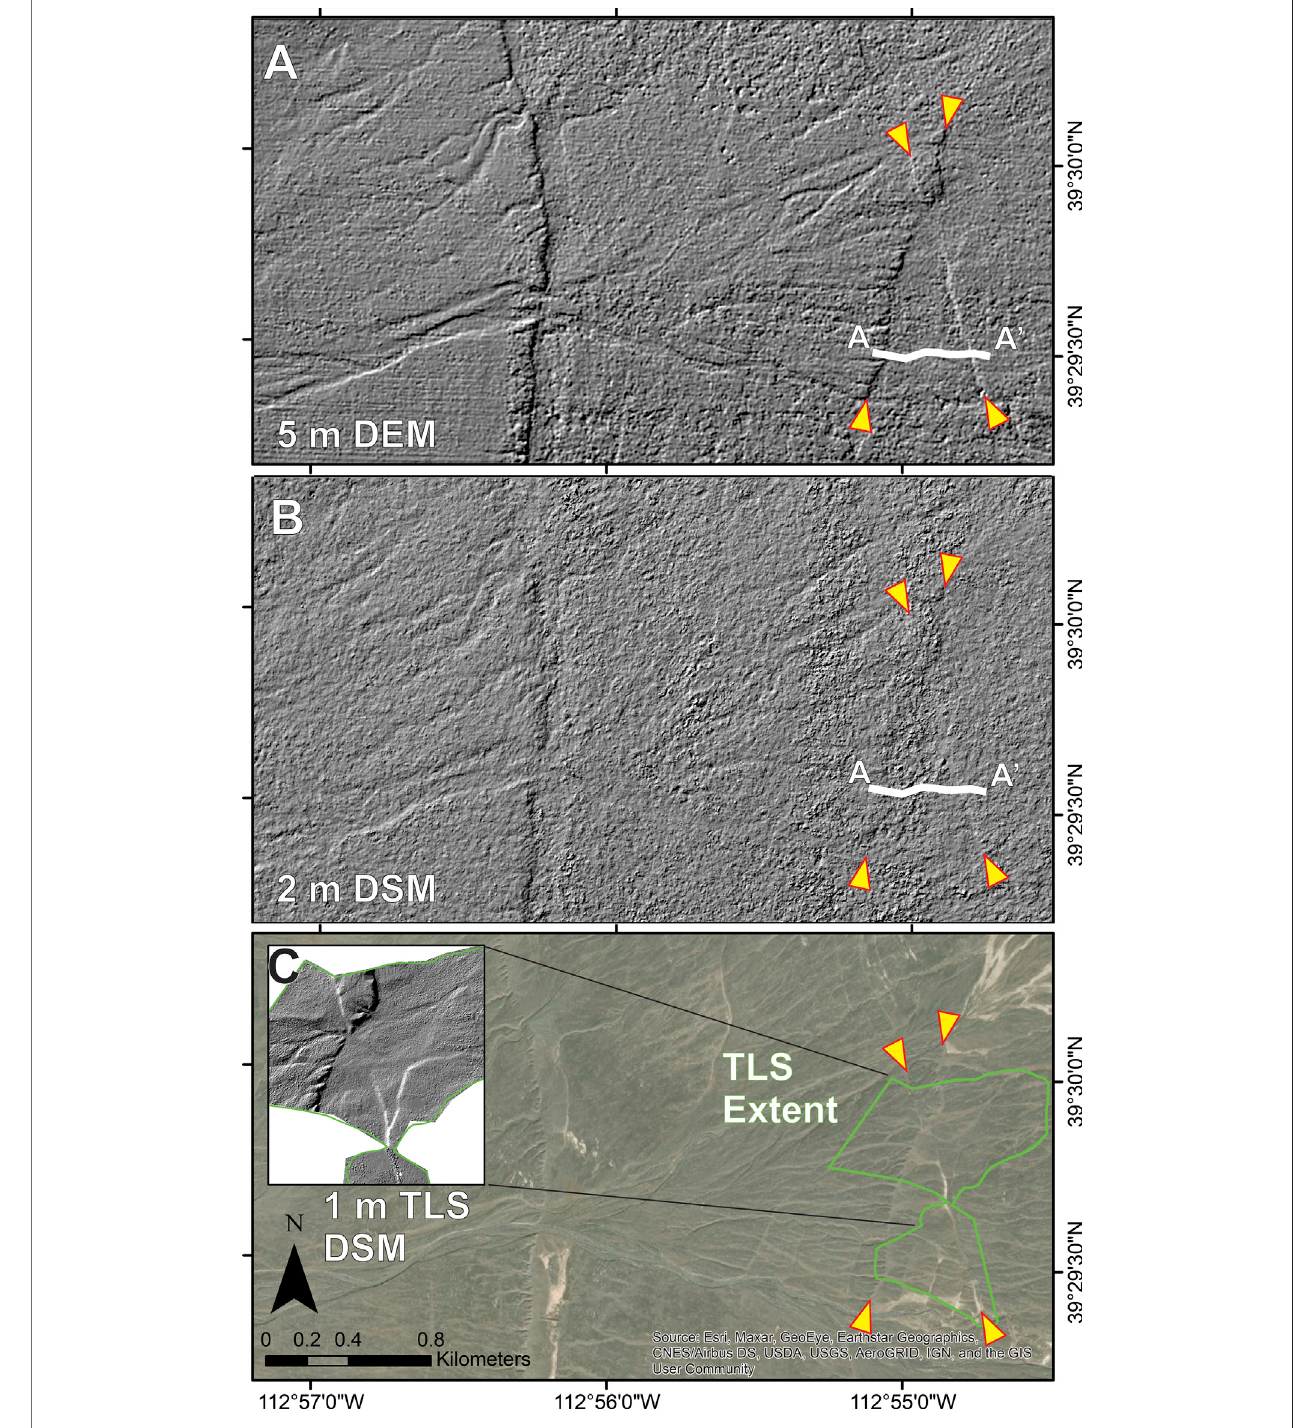
FIGURE5| Acomparison ofthe5-mDEM,2-mDSM, andTLSDSMinaswathfromthewestern-most faulttrace(c.7.5 mverticalseparation)inthecentralpartof the DMFZ. The traces of two cross-cutting antithetic faults are indicated by yellow arrows in all fi gures. Secondary traces within the graben are highlighted by light- colored, fi ne-grained alluvium in (C) . Location of topographic pro fi le A-A ’ ( Figure 6 ) shown in white. Scale and coordinates in (C) apply to (A) and (B) .